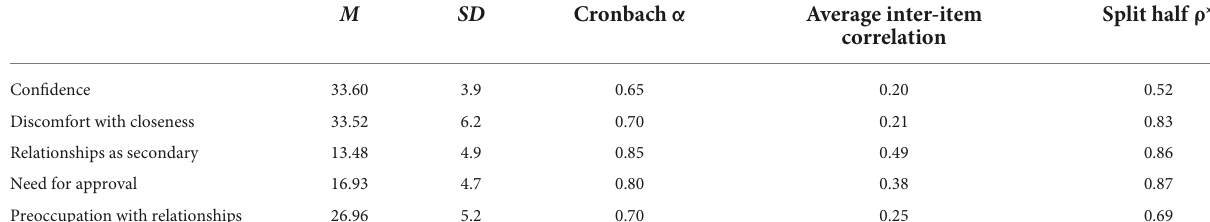
TABLE 1 Mean, SD, Cronbach’s alpha, average interitem correlation, and split half ρ related to the five dimensions of the Attachment Style Questionnaire.